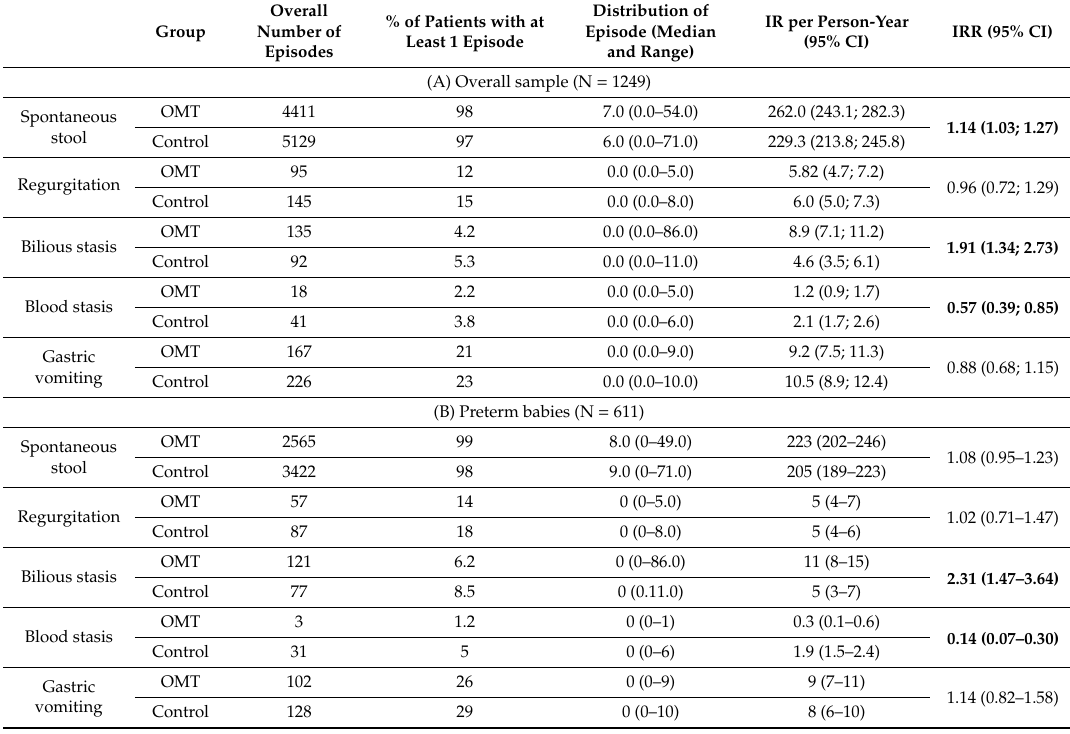
Table 3. Other clinical end-points. Results of Poisson